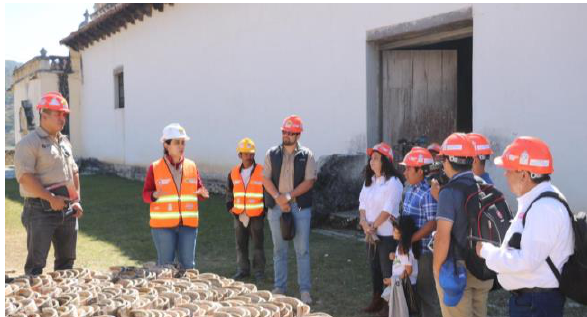
Figure 4. Guided OR program tour to regional media at the first period of restoration works in San Manuel de Colohete. Source: http://www.aecid.hn/sitio/index.php/noticias/531-inician-los- trabajos-de-restauracion-de-la-iglesia-de-la-inmaculada- concepcion-de-san-manuel-de-colohete.